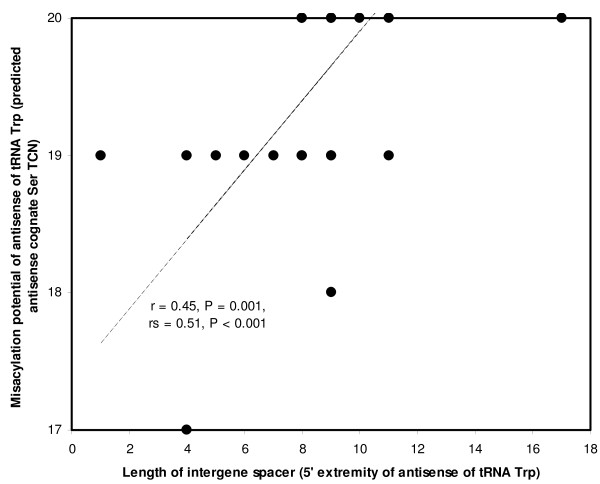
Misacylation potential of antisense of tRNA Trp as a function of processing inaccuracy of its 5' extremity by sense RNA maturation. The x axis is the number of nucleotides between the next sense gene (tRNA Ala) and the 5' extremity of the antisense of tRNA Trp. Datapoints are for the same species as in Figure 3, but species excluded for lack of anticodon symmetry between sense and antisense tRNAs differ.